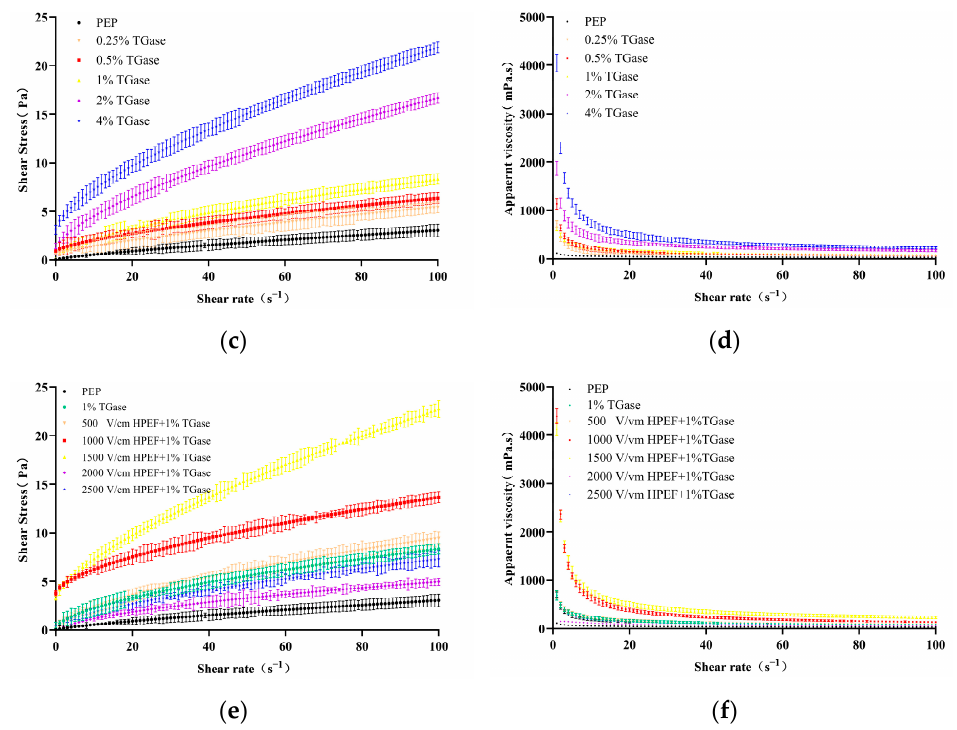
Figure 6. The effects of HPEF (500, 1000, 1500, 2000, and 2500 V/cm), TGase (0.25, 0.5, 1, 2, and 4%), and compound treatment (HPEF-500, 1000, 1500, 2000, 2500 V/cm; 1% TGase) on the shear stress and apparent viscosity of PEP. ( a ): Shear stress of PEP treated with HPEF (500, 1000, 1500, 2000, and 2500 V/cm); ( b ): Apparent viscosity of PEP treated with HPEF (500, 1000, 1500, 2000, and 2500 V/cm); ( c ): Shear stress of PEP treated with TGase (0.25, 0.5, 1, 2, and 4%); ( d ): Apparent viscosity of PEP treated with TGase (0.25, 0.5, 1, 2, and 4%); ( e ): Shear stress of PEP treated with HPEF and TGase (HPEF-500, 1000, 1500, 2000, 2500 V/cm; 1% TGase); ( f ): Apparent viscosity of PEP treated with HPEF and TGase (HPEF-500, 1000, 1500, 2000, 2500 V/cm; 1% TGase). Table 2. Power-law model of PEP under different HPEF (500, 1000, 1500, 2000, and 2500 V/cm) pre- treatments. HPEF (V/cm) K N R 2 PEP 0.0885